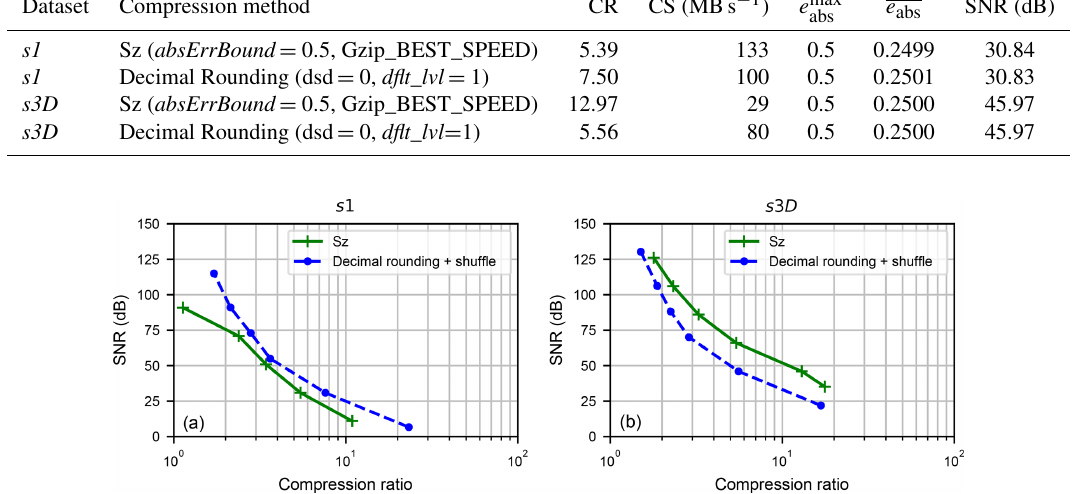
Figure 4. Comparison of the compression results (SNR vs. compression ratio) of the Sz and Decimal Rounding algorithms in absolute error-bounded compression mode, on the s1 dataset (a) and s3D dataset (b) .